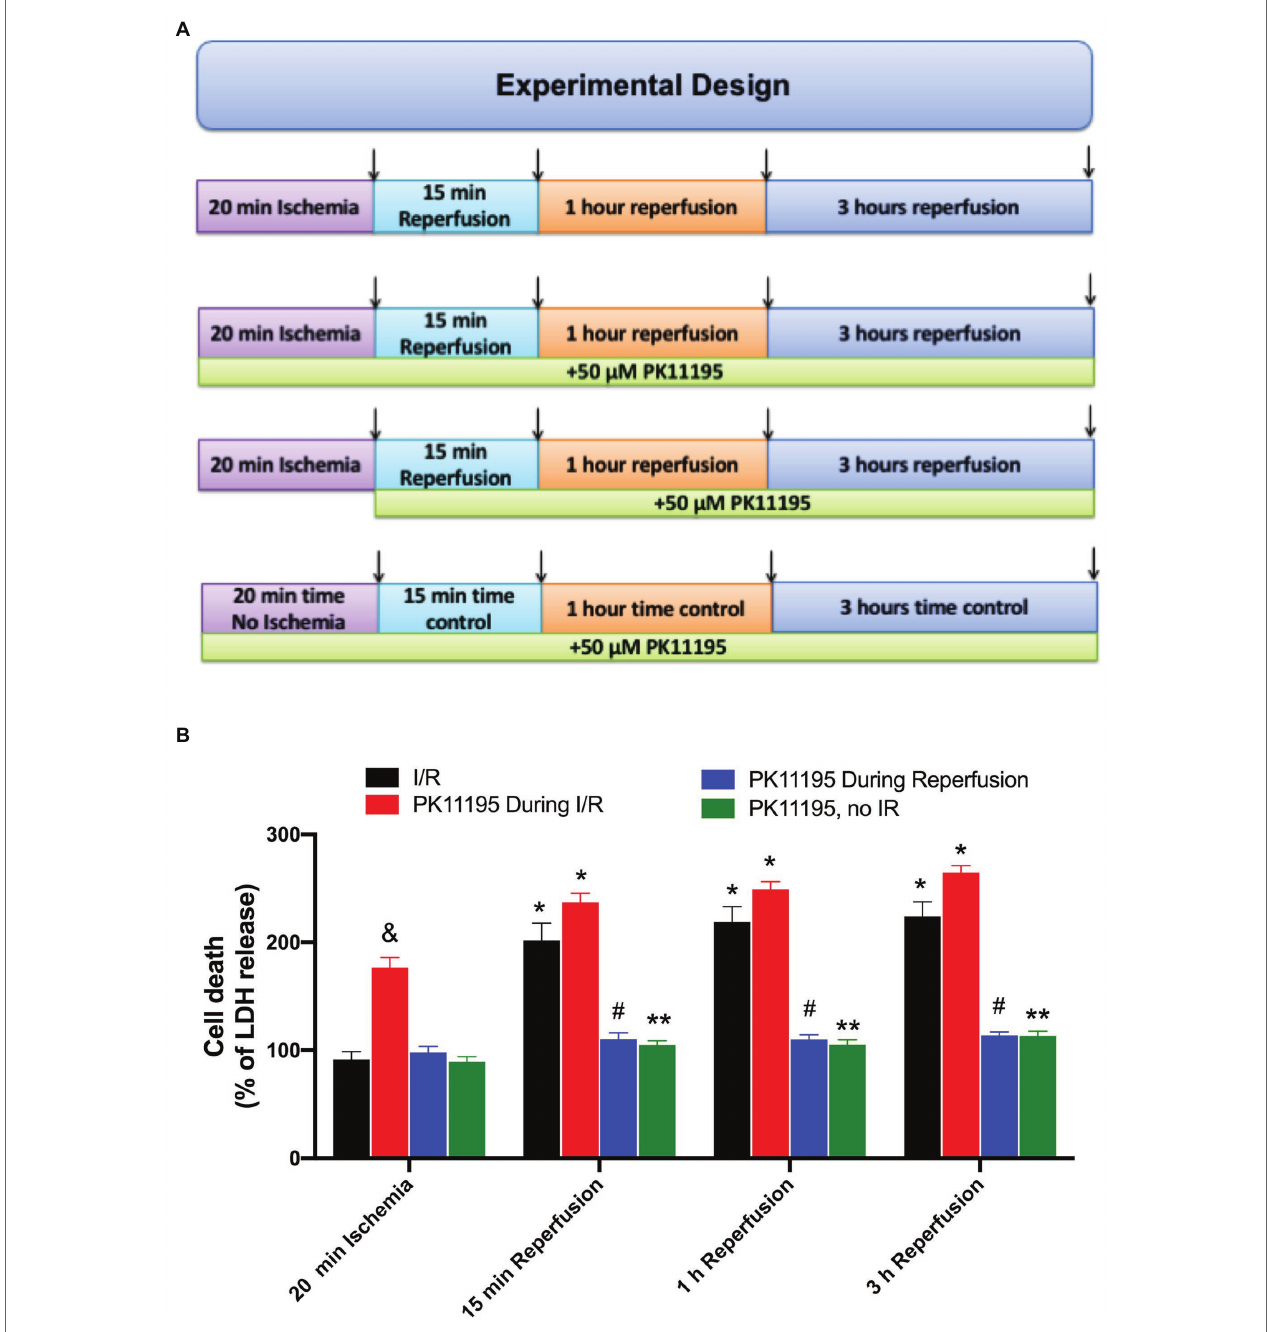
FIGURE 1 | Effects of PK11195 compound on cell death in conditions of simulated ischemia and reperfusion. (A) Schematic representation of experimental design. Freshly isolated ventricular myocytes were exposed to 20 min of simulated ischemia, followed by simulated reperfusion as shown in the upper panel. At the end of 20 min ischemia, and 15 min, 1 h, and 3 h of reperfusion, samples were collected for lactate dehydrogenase (LDH) detection as shown by arrows. Control experiments were done in the absence of 50 μ M PK11195, while in the second set of experiments, 50 μ M PK11195 was present during both simulated ischemia and reperfusion, and in the third set of experiments, 50 μ M PK11195 was added only during reperfusion phase. The fourth set of experiments was a time no I/R control in the presence of 50 μ M PK11195. (B) Cell death following ischemia-reperfusion as measured by LDH release was significantly decreased by 50 μ M PK11195 only when added at the onset of the reperfusion. Green bars represent time control in the presence of 50 μ M PK11195 but in the absence of I/R. Data expressed as mean ± SEM. n = number of cell preparation from six different animals per experimental group. * p < 0.05 reflects the increase in cell death in reperfusion vs. ischemia in each group; # p < 0.001 reflects the decrease in cell death in PK11195-treated cells during reperfusion vs. untreated cells; & p < 0.001 reflects the increase in cell death in PK11195 treated cells during ischemia vs. ischemia in the absence of PK11195 in each group; ** p < 0.001 reflects the difference between PK11195, no I/R vs. I/R and PK11195 during